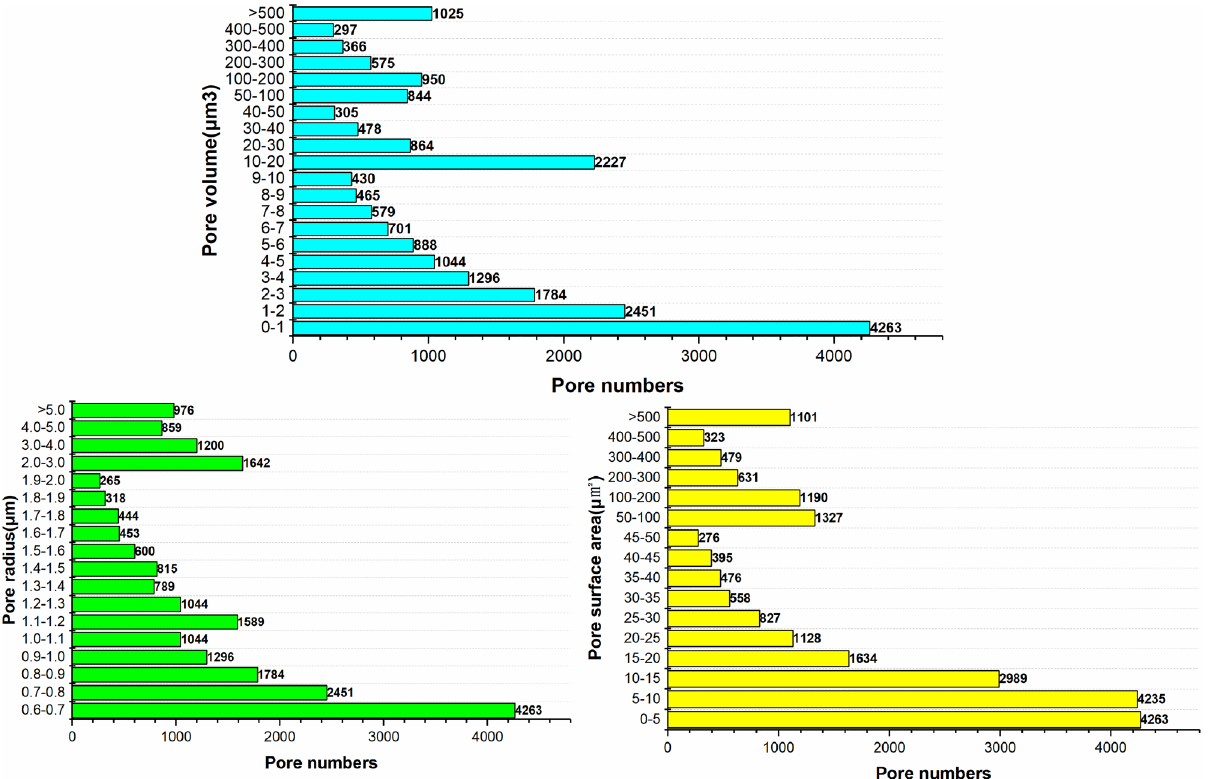
Figure 18. Statistics of pore quantitative parameters of nylon-uncured rubber